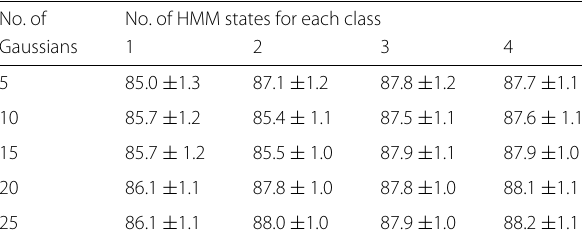
Table 2 Accuracy (in %) of the audio segmentation system with different number of HMM states and component Gaussians No. of